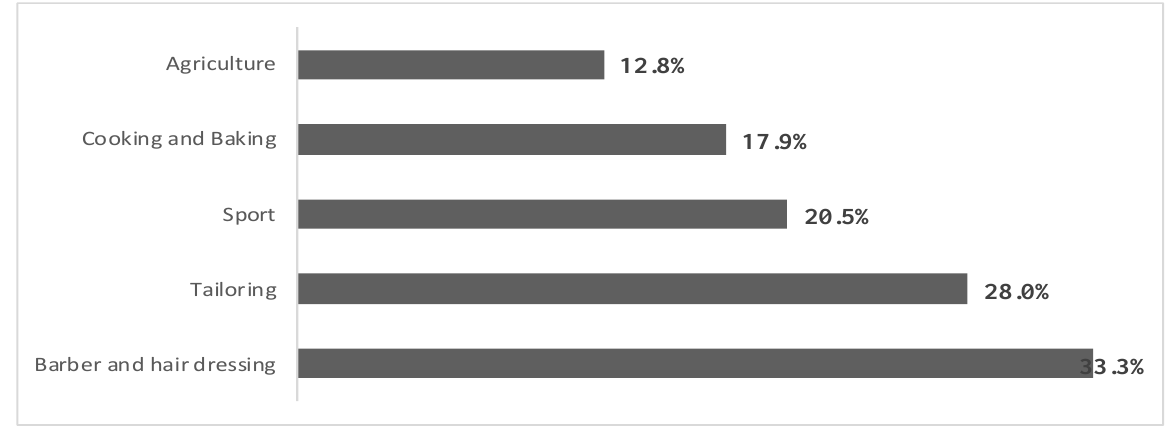
Figure 1: Skills acquired by the Children at the Rehabilitation Centres; Source: Field Data